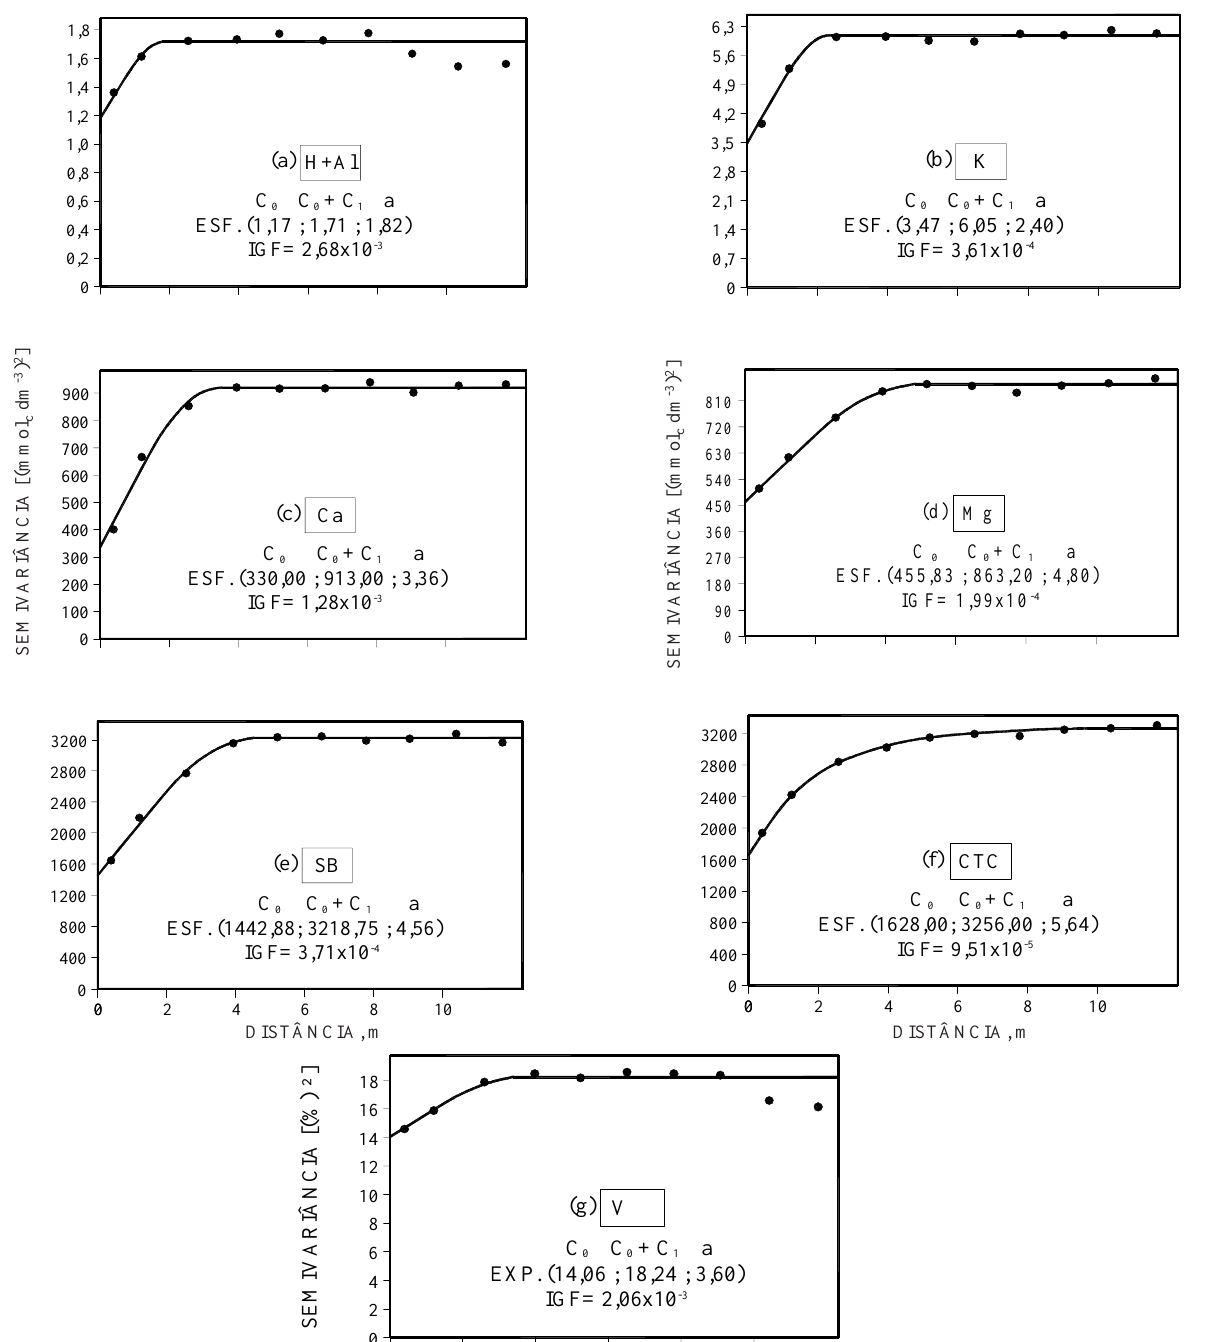
Figura 2. Semivariogramas dos atributos do solo: (a) acidez potencial (H + Al), (b) potássio, (c) cálcio, (d) magnésio trocáveis, (e) soma de bases, (f) capacidade de troca catiônica e (g) índice de saturação por